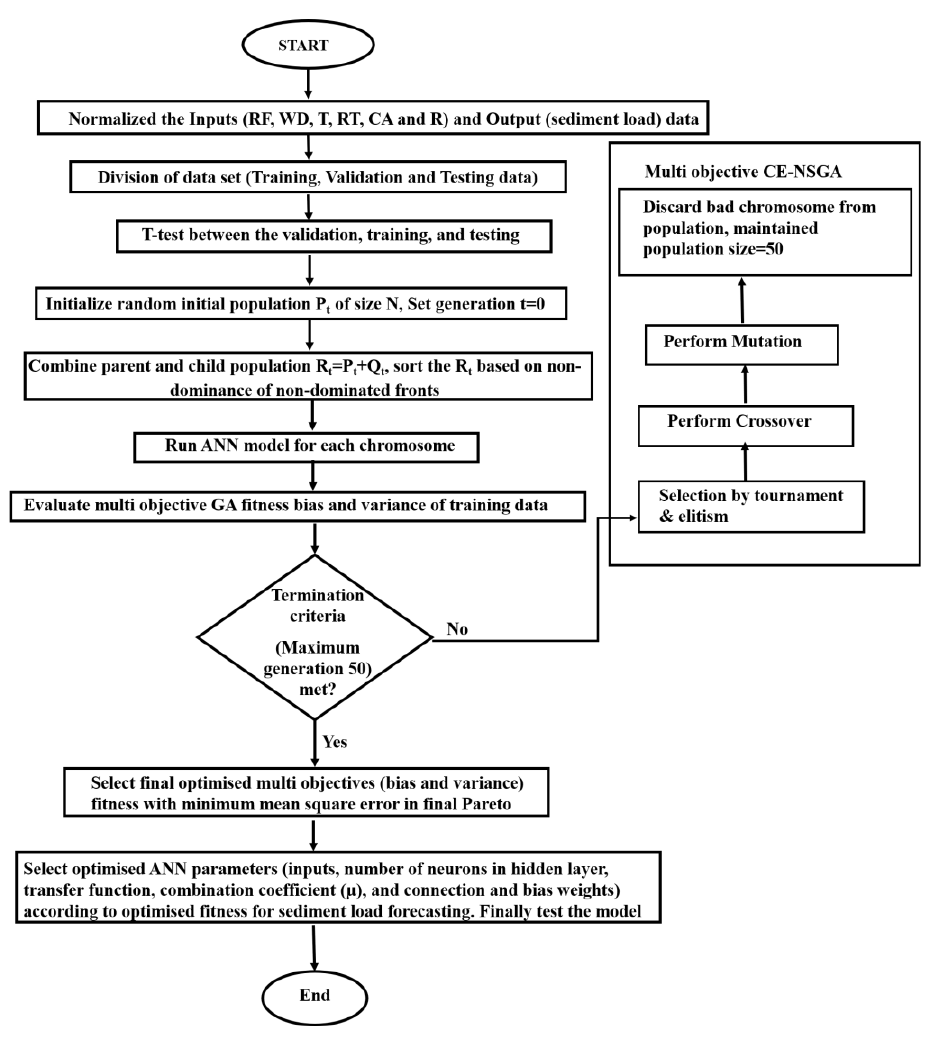
Figure 2. Flow chart of proposed hybrid ANN-MOGA model for SL forecasting.